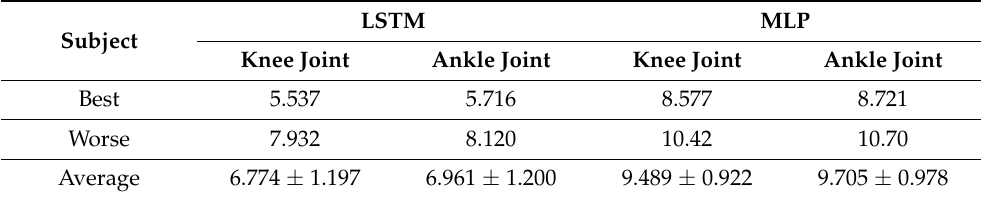
Table 1. Root mean squared error (RMSE) results for both model in two